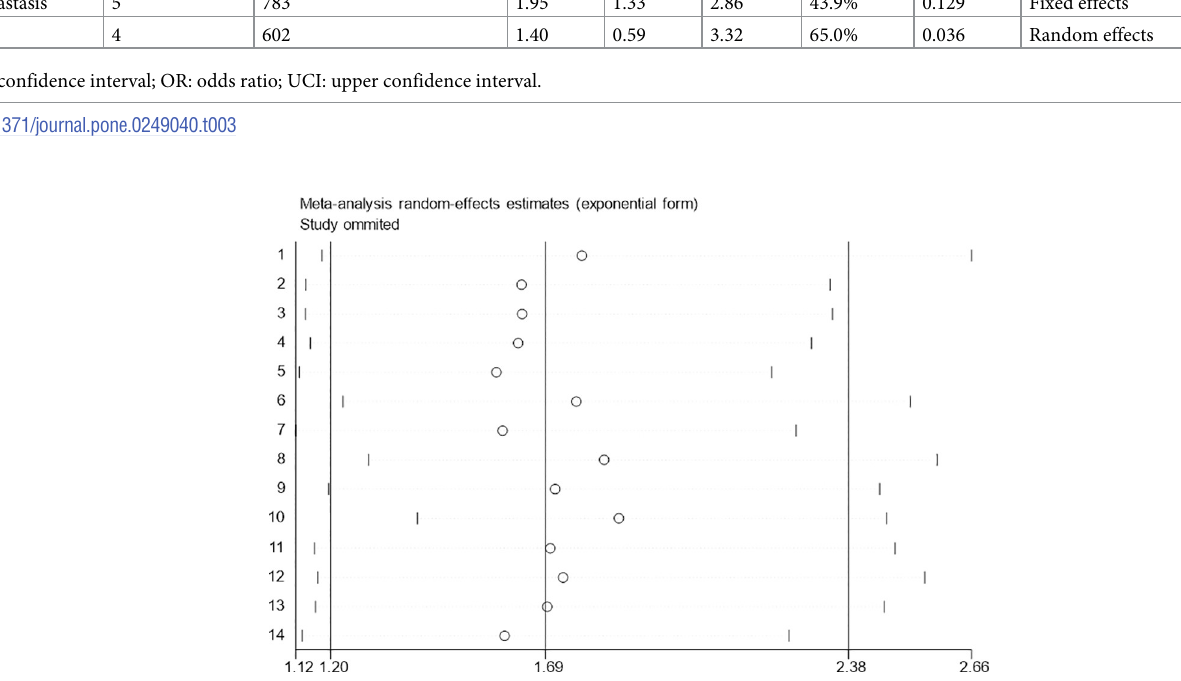
Fig 11. Sensitivity analysis of the relationship between GPRC5A expression and OS.